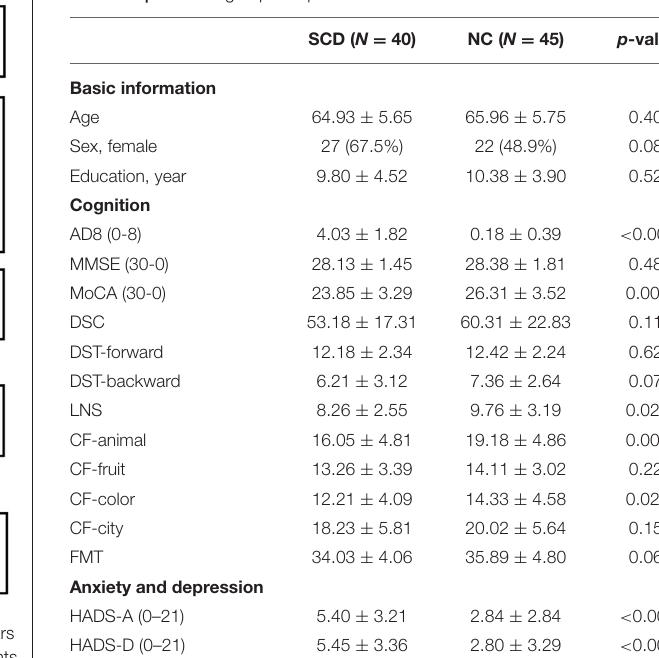
TABLE 1 | Between group